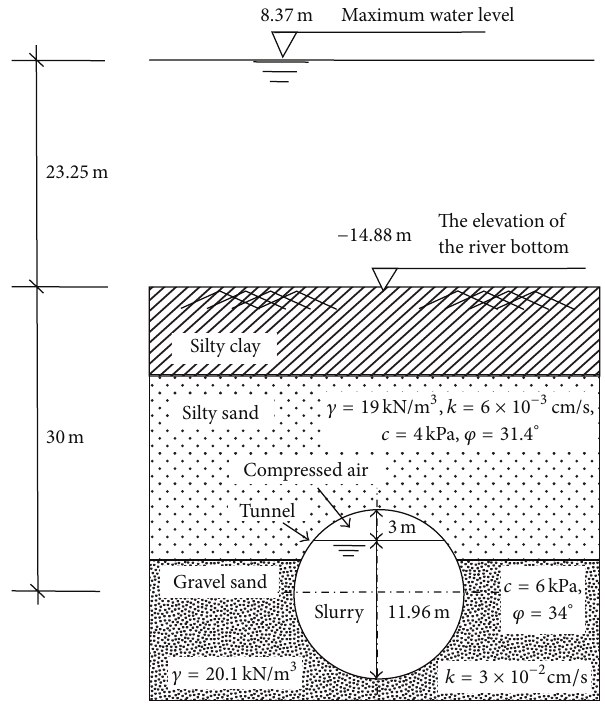
Figure 6: Sectional view of geological strata of the stop location of tunnel machine.